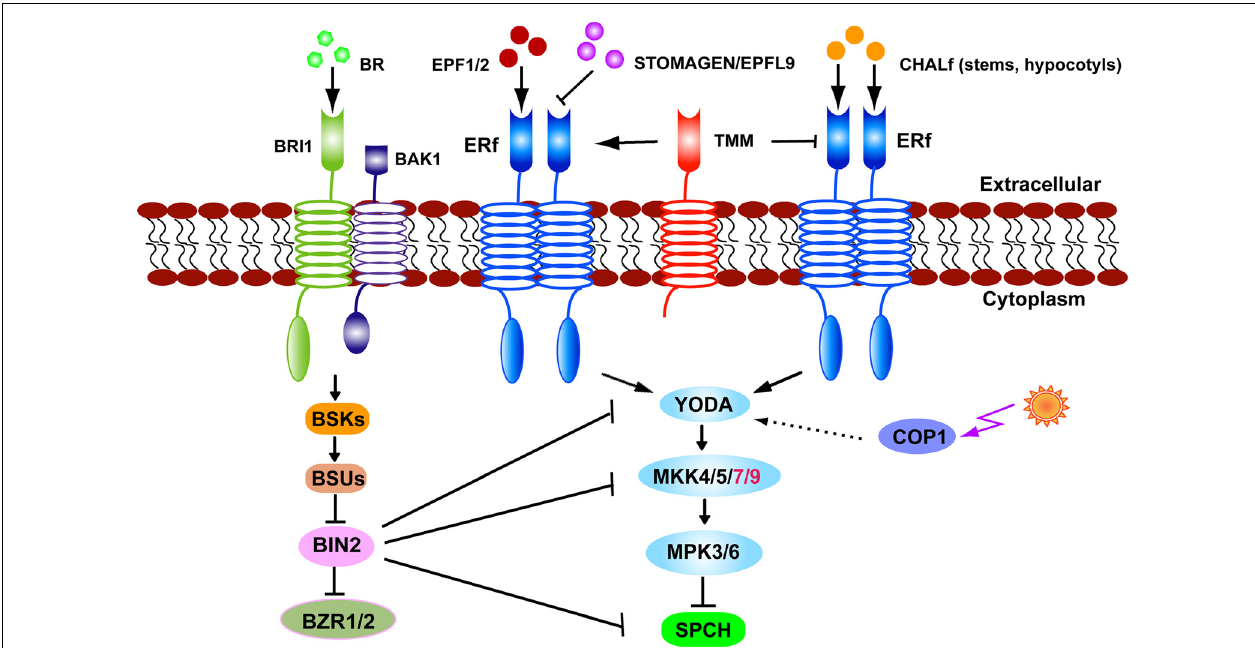
FIGURE 2 |The stomatal signaling pathway. EPF1, EPF2, and STOMAGEN/EPFL9 signals are received by TMM–ERf leading to transduction and the YODA–MKK–MPK cascade. Light regulates stomatal production via COP1 which is upstream of YODA. In stems or